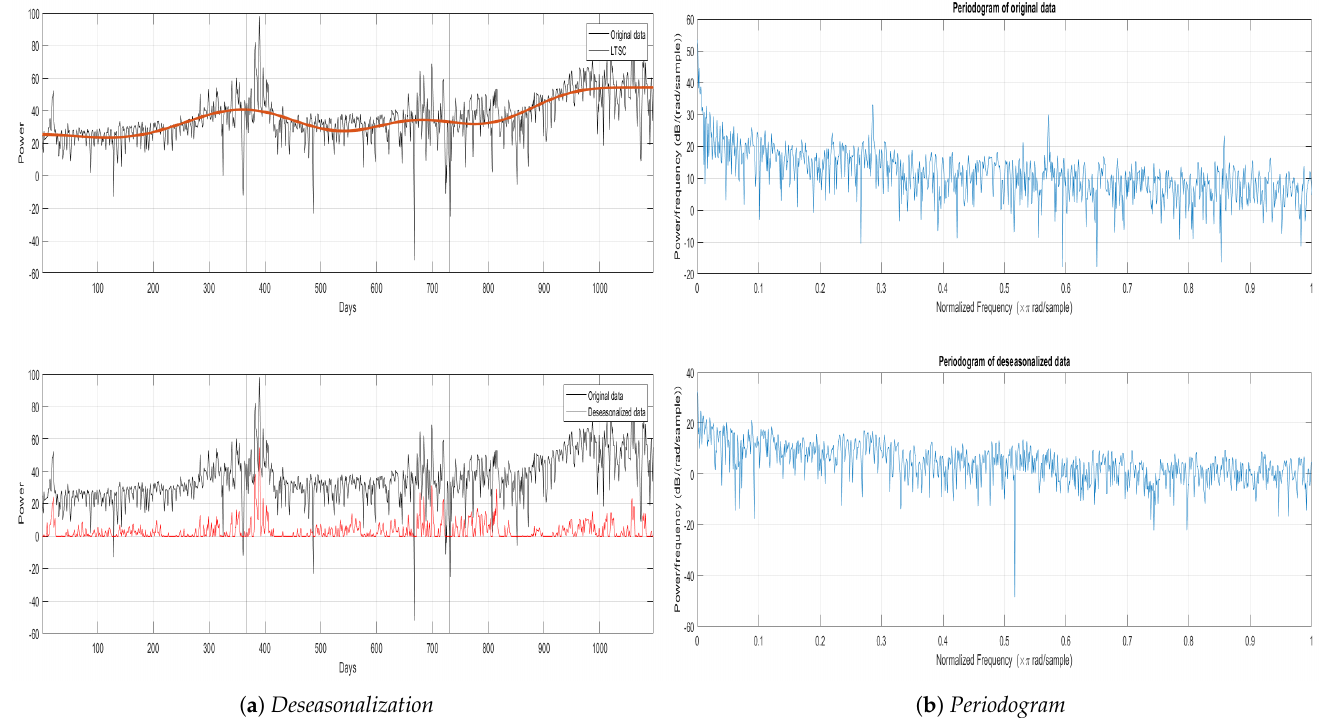
Figure 3. Example of results of “deseasonalize” on the three